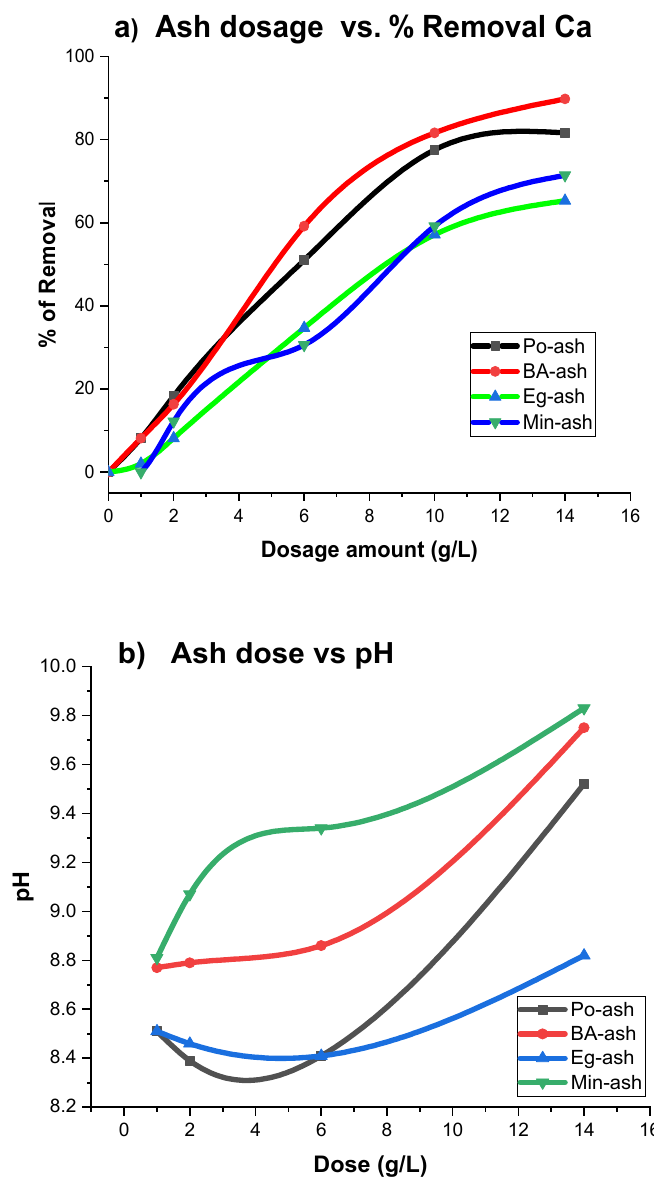
Figure 9. ( a ) Influence of ash dose versus Ca removal; ( b ) influence of ash dose versus pH.